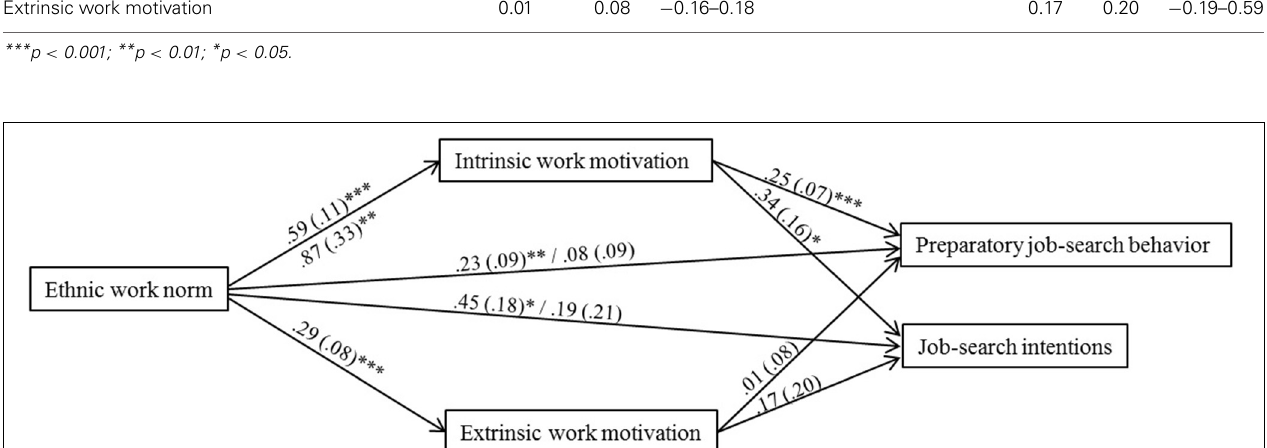
all personality types are depicted above the arrows. Arrows from ethnic work norm to preparatory job search behavior and job search intentions depict the relations without controlling for work motivation, followed by the relations controlled for work motivation. ∗∗∗ p < 0 . 001; ∗∗ p < 0 . 01; ∗ p < 0 .